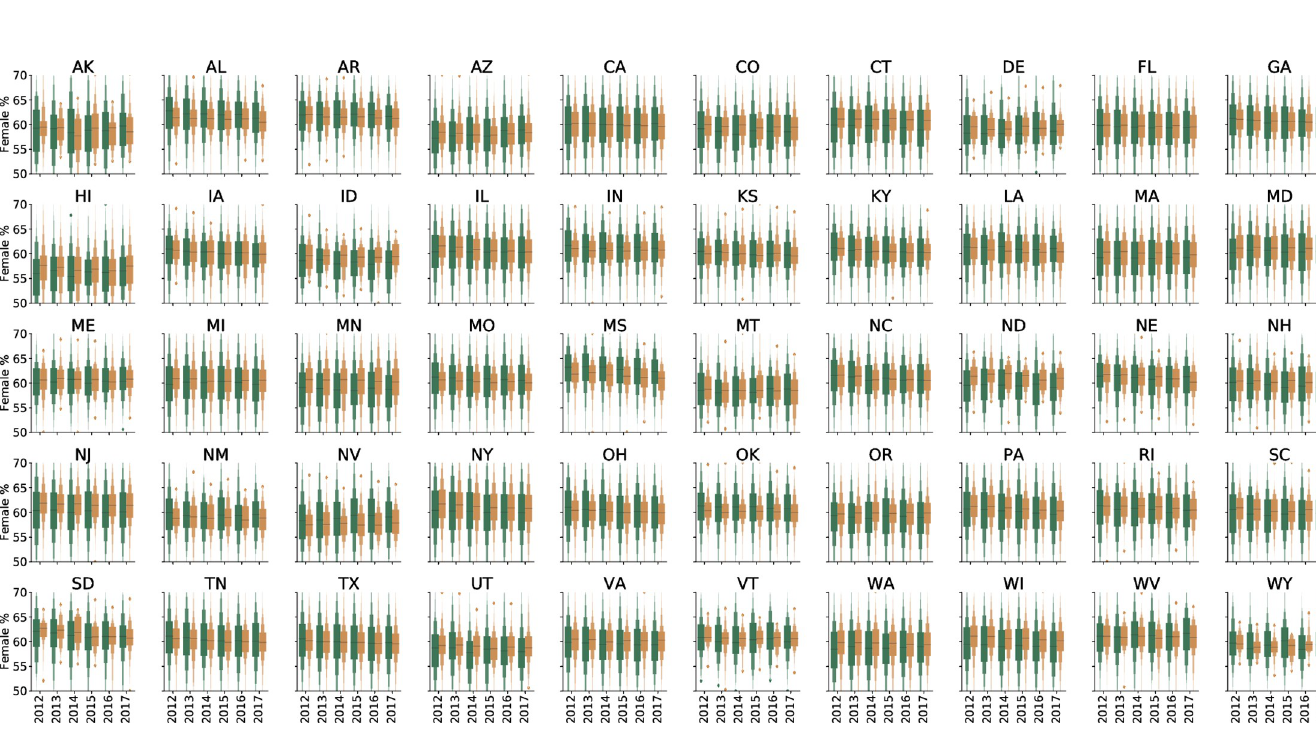
PLOS ONE | https://doi.org/10.1371/journal.pone.0227783 September 14, 2020 5 /